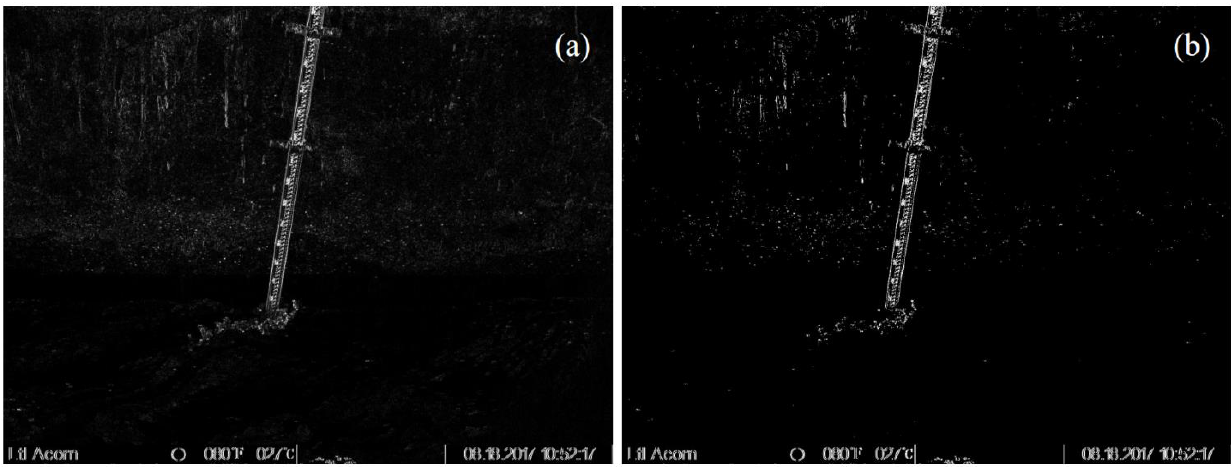
Figure 7. ( a ) Sobel-Operated image from Figure 6b. ( b ) The OTSU method for binarization operation from ( a ).